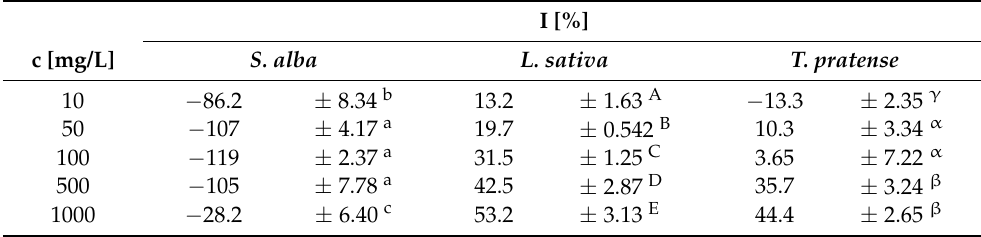
Table 5. The inhibition of root elongation (calculated as a percentual inhibition of root growth compared to control) of white mustard ( Sinapis alba ), lettuce ( Lactuca sativa ) and clover ( Trifolium pratense ) after 3 days of seed germination in a solution supplemented with Zn 3 BO 6 at concentrations of 10, 50, 100, 250, 500 and 1000 mg/L. Standard deviation is represented as ± S.D. ( n = 3), and two-way ANOVA test with Dunnett’s multiple comparisons was